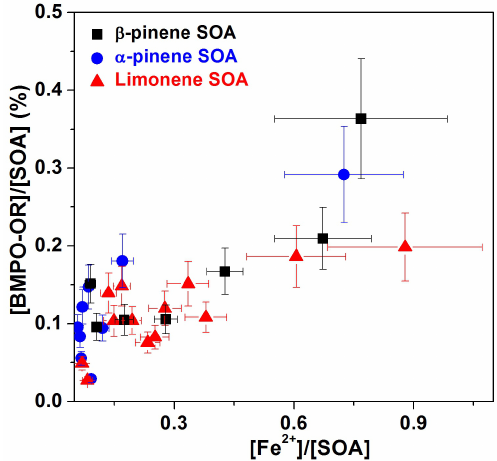
Figure 6. Formation efficiency of organic radicals. Molar concen- tration ratio of organic radicals to SOA ([BMPO-OR] / [SOA], in %) in mixtures of Fe 2 + and SOA